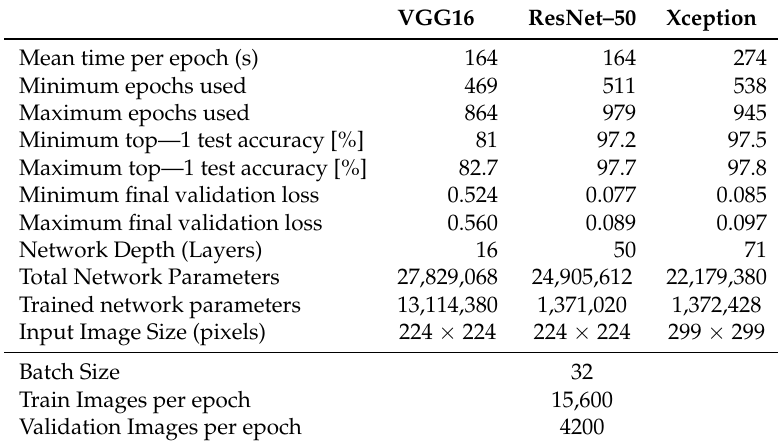
Table 2. General information about the three neural networks